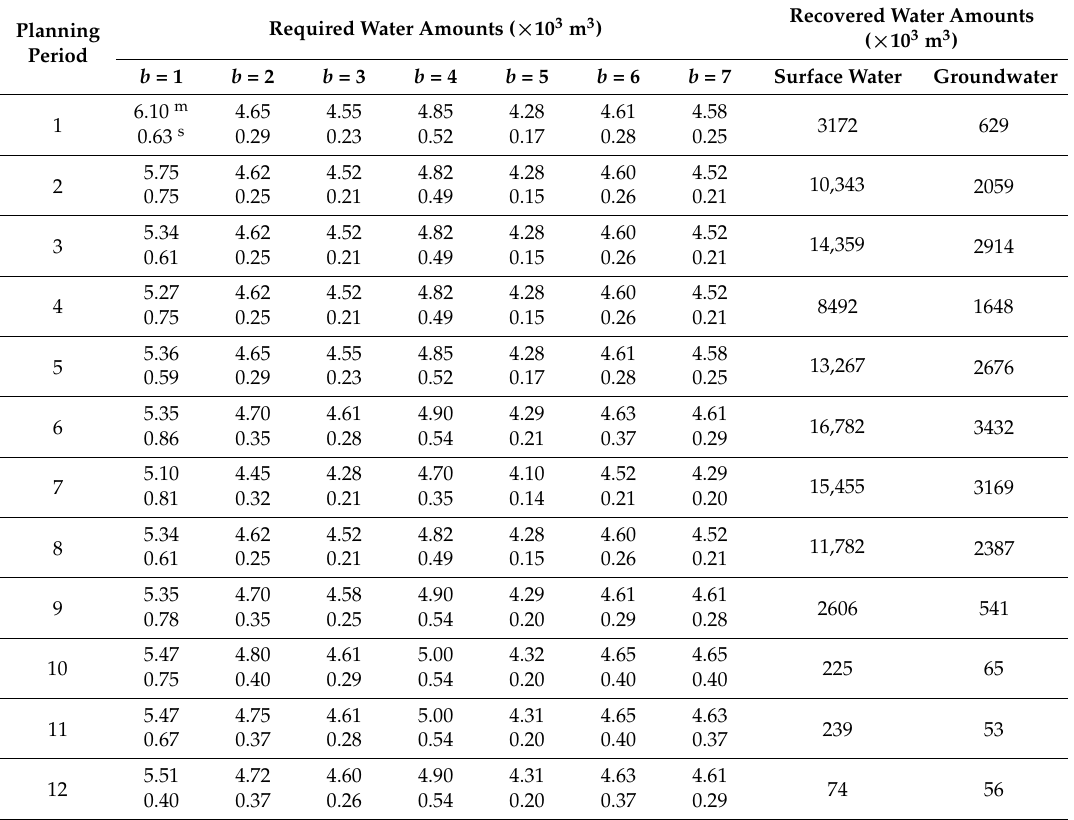
Table 3. System parameters over the twelve planning